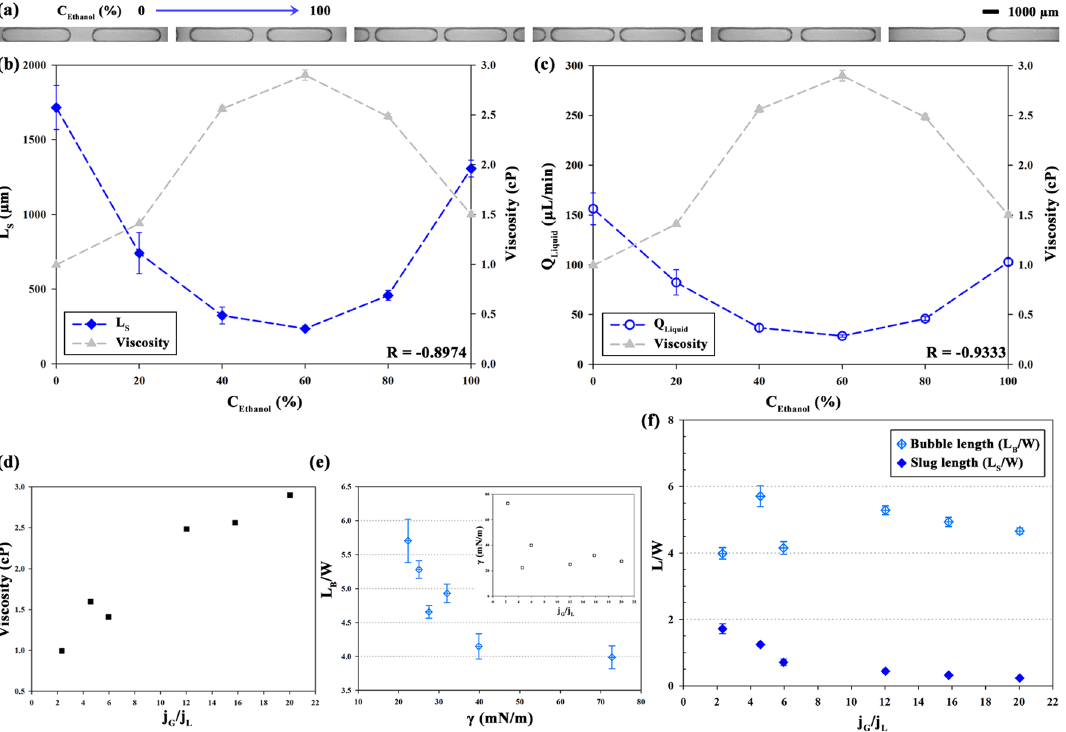
Figure 5. ( a ) Representative images in 3D-printed chip depending on the volume percent of ethanol [ C Ethanol (%)] for ethanol–water mixture. ( b ) Length ( L S ) and ( c ) flow rate ( Q Liquid ) of slugs depending on the viscosity of liquid depending on C Ethanol . Viscosity of ethanol–water mixture was overlapped depending on C Ethanol (%). Correlation coefficients for the viscosity of liquid are R = –0.8974 ( L S ) and R = –0.9333 ( Q Liquid ). ( d ) Air–liquid superficial velocity ratio ( j G / j L ) depending on viscosity. ( e ) Length of bubble ( L B /W) with surface tension (γ) and the plot of surface tension (γ) with j G / j L in the inset. ( f ) Dimensionless length ( L S /W, L B /W) versus j G / j L Liquid resistance with ethanol concentration. The resistance of liquid part ( R Liquid ) is changed by varying the viscosity of the liquid sample used as the working fluid. In this study, R Liquid is proportional to the viscosity of the mixture of ethanol and water, as expressed in Eq. (4). The viscosity of the mixture varies with ethanol concentration (volume percent of ethanol; C Ethanol ). The Q Pump is fixed at 500 µL/min and C Ethanol is varied from 0 to 100%. Figure 5a–c illustrates L S and Q Liquid depending on C Ethanol , and the overlapped viscosity (Pa s/ mm 3 ) of ethanol–water mixture, which was measured under the same condition of C Ethanol . The viscosity of mix- ture has the highest value at 60% of C Ethanol . Based on the viscosity, the minimum and maximum values of R Liquid are 0.32 and 0.94 Pa s/mm 3 , respectively, at relevant C Ethanol . The increase in R Liquid results in the decrease in the flow rate of the liquid ( Q Liquid ) at constant Δ P (Δ P = R Liquid Q Liquid ). The value of L S is the minimum ( L S = 233 µm) at C Ethanol = 60%, and the maximum ( L S = 1716 µm) for water, i.e., at C Ethanol = 0%. The values of Q Liquid also show a similar trend with a minimum value ( Q Liquid = 28 µL/min) at C Ethanol = 60% and a maximum value ( Q Liquid = 156 µL/min) at C Ethanol = 0%. Both parameters have the minimum value at 60% of C Ethanol , which is in accordance with the maximum viscosity of the working fluid. The correlation coefficient between the viscosity of ethanol–water mixture and Q Liquid is R = − 0.9333, and between L S and Q Liquid is R 2 = 0.9705. For detailed analysis, Fig. 5d–f represent the variation of j G / j L and normalized length of slug and bubble. Figure 5d shows the change of j G / j L with viscosity of mixture because viscosity is related with j G / j L linearly in general since Q Liquid decreases with increased R Liquid (Eqs. (1) and (4)). In Fig. 5e, the relation within L B /W, j G / j L , and surface tension (γ) was depicted since γ has relevance to the force balance for generating the segmented flow. L B /W decreases with increased γ, and the inset shows the surface tension is inversely proportional to j G / j L . From that, high value of j G / j L is under the conditions of relatively high viscosity and low γ while low j G / j L is under the opposite. In Fig. 5f, L S /W is decreased with j G / j L since the R Liquid is increased by viscosity of liquid. By comparison, L B /W is remarkably affected by the variation of surface tension and density, especially in the lower j G / j L range ( j G / j L = 2.33 ~ 5.96). In this part, high j G / j L with low L B /W means that air occupies large proportion with small-size air bubble at high generation rate. Pump flow rate. To investigate the effect of negative pressure on the segmented flow, the Q Pump of the syringe pump was controlled. From Eq. (1), Δ P increases with increased Q Pump when R h is constant. The length of the tube for R Air (76 Pa s/mm 3 ) was 400 mm and C Ethanol for R Liquid (0.32 Pa s/mm 3 ) was 100%. The values of Q Pump were changed as 300, 500, 700, 1000, and 1500 µL/min. In Fig. 6a, for the case of low Q Pump (300, 500 µL/min),